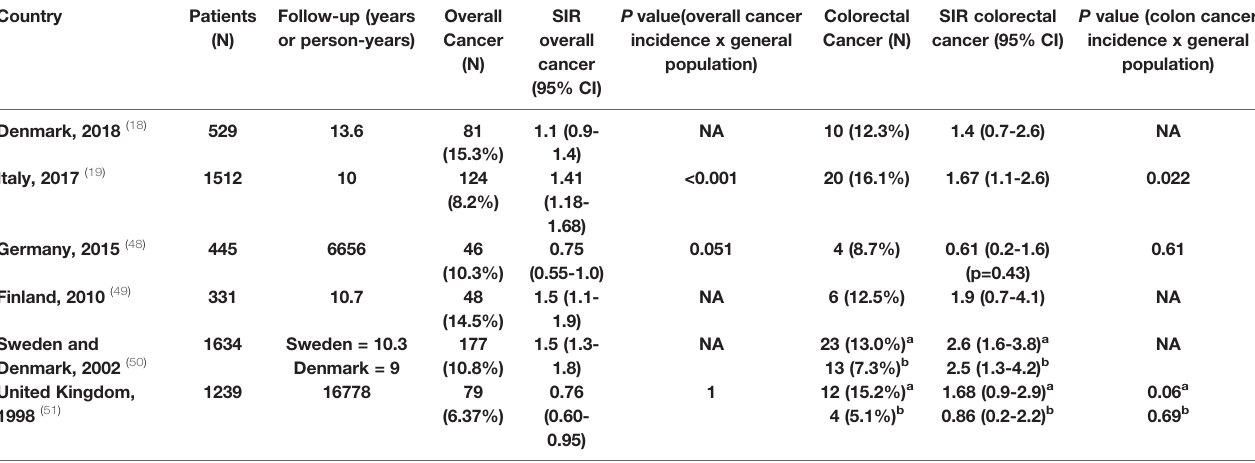
TABLE 1 | Overall cancer and colorectal cancer incidence in acromegaly in nationwide studies.